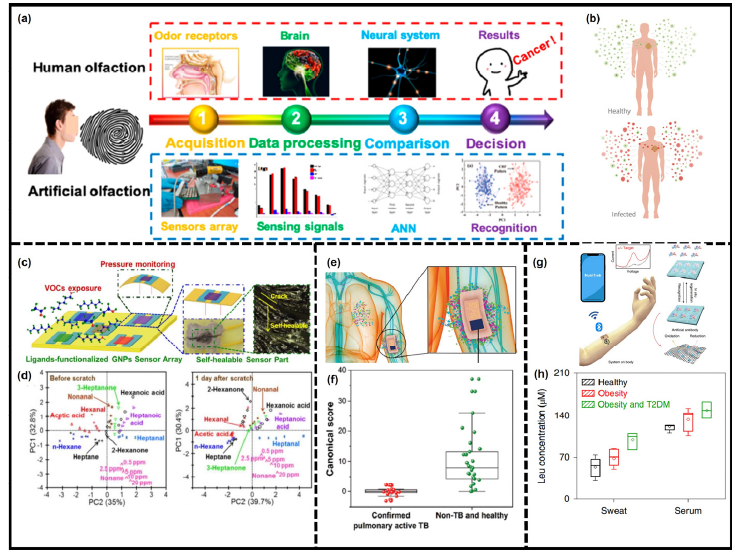
Figure 9. The wearable systems used in biochemical biomarkers monitoring. ( a ) Schematic of breath